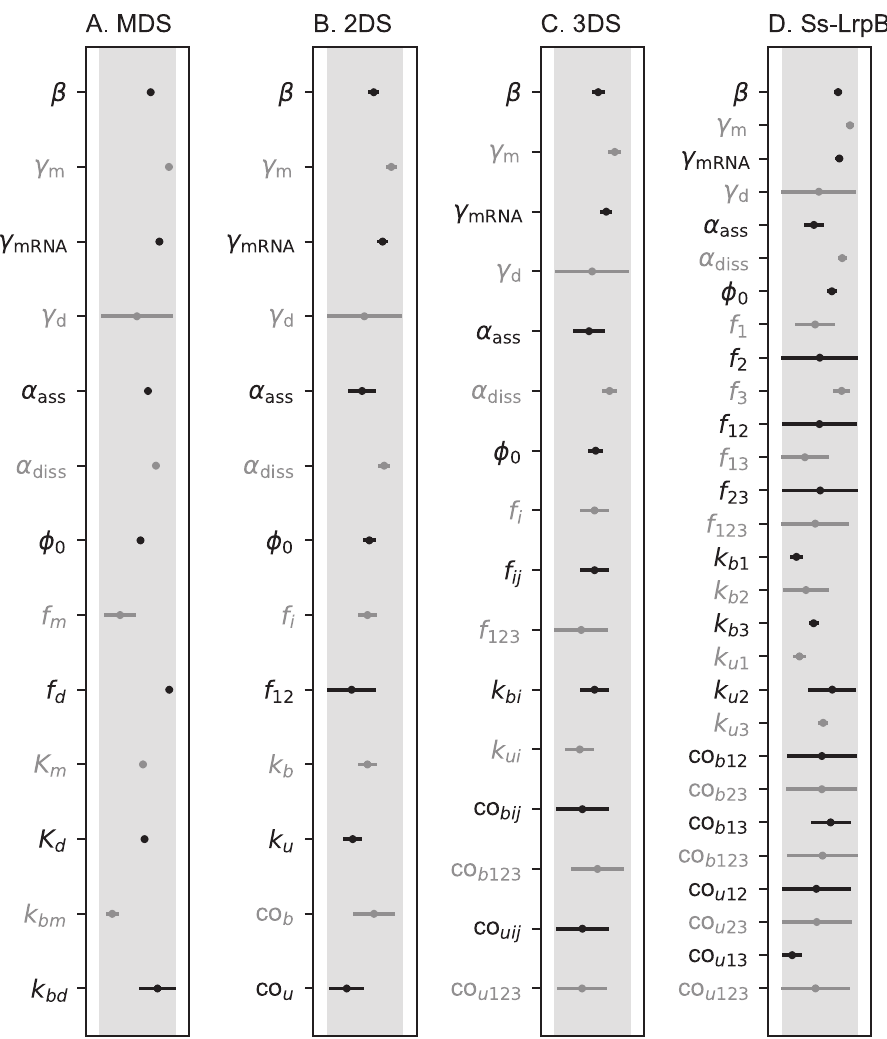
Fig 4. Oscillatory solutions for the different toy models. The shaded region represents the physiological range. The black and gray lines represent the mean oscillatory ranges for the different parameters. The axis is logarithmically scaled, the length of the lines thus represent fold ratios. The line for each parameter is scaled according to the physiological range of this parameter. Ranges are very small for the MDS and become wider for the 2DS and 3DS.